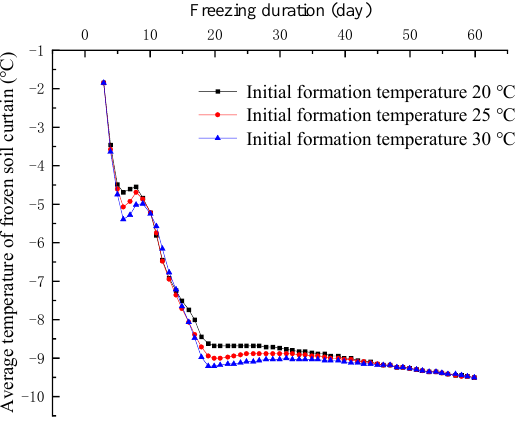
Figure 9. The average temperature of frozen soil curtain for different initial formation.